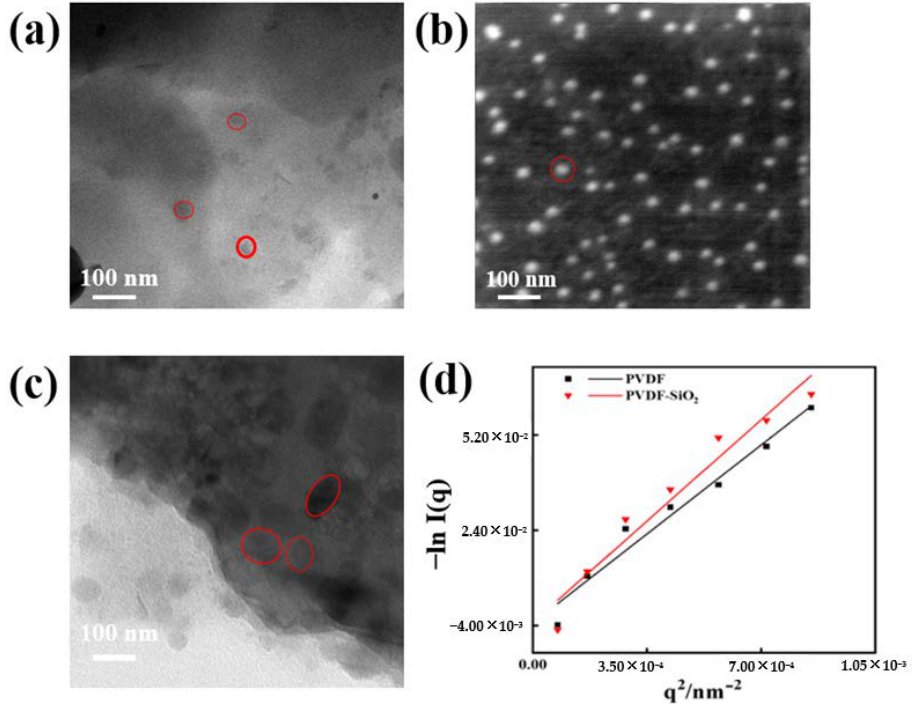
Figure 3. The dispersion state of nano-silica in the PVDF matrix. ( a ) TEM images of 20 nm SiO 2 ( b ) TEM-HADDF image of 30 nm SiO 2 . ( c ) TEM images of 50 nm SiO 2 ; ( d ) Linear fitting of SLS results of pure PVDF and PVDF/0.5 wt% 30 nm SiO 2